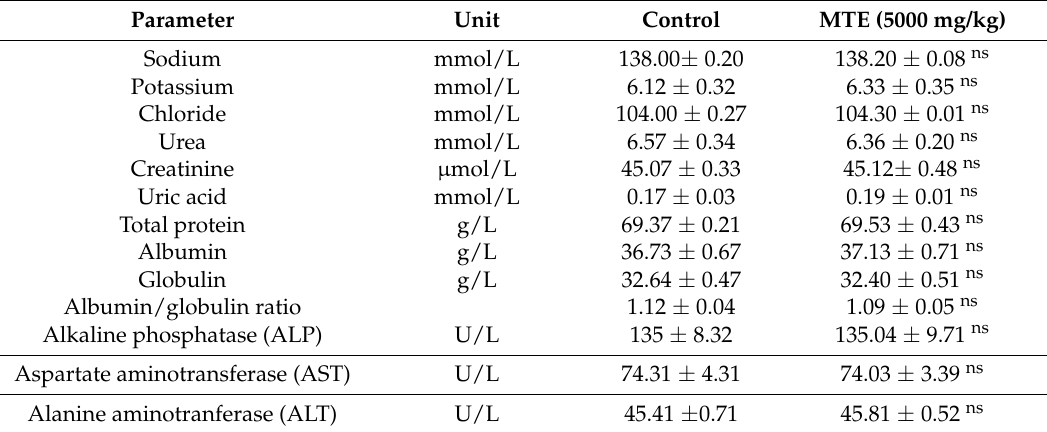
Table 3. Effect of MTE on biochemical parameters in acute oral toxicity